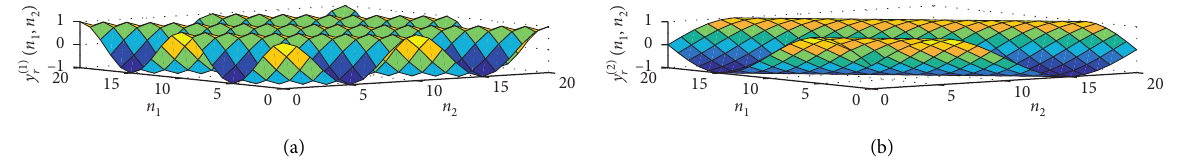
Figure 1: Reference surfaces y ( 1 )